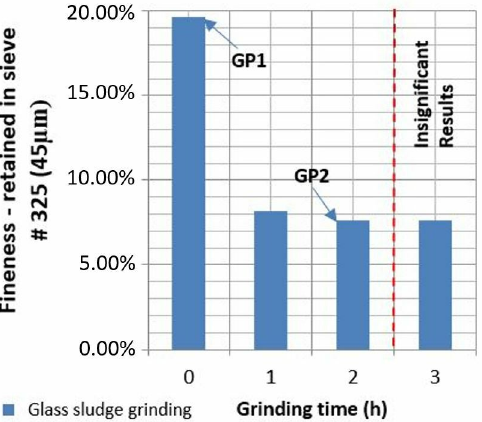
Figure 7. Process from polishing and lapping the glass to grounding for incorporation into concrete.